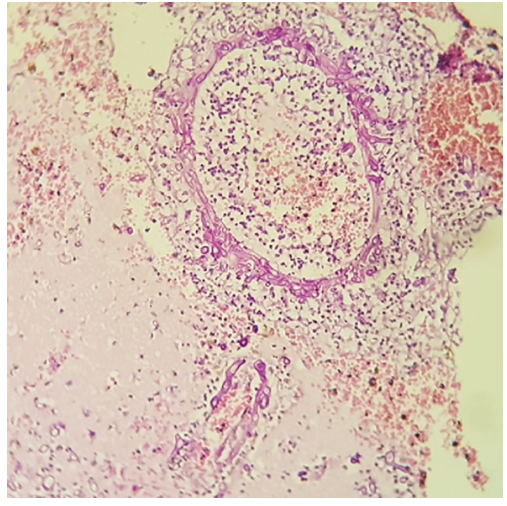
Figure 5b - B, Ring-shaped brain lesion with accumulation of mucormycosis bacilli (hyphae). Hematoxylin and eosin, x 400.